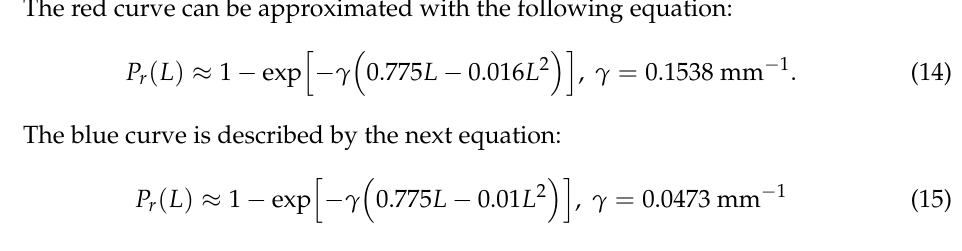
Figure 8. Dependencies of the reflection coefficient P r on the Gaussian beam width at d = 0.65 µ m, λ = 1.06 µ m, θ = 0, γ = 22.02 mm − 1 (red curve), d = 1.30 µ m, λ = 1.09 µ m, θ = 0, γ = 11.1 mm − 1 (blue curve) ( a ); d = 0.78 µ m, λ = 1.23 µ m, θ = π /18, γ = 0.15 mm − 1 (red curve), d = 1.52 µ m, λ = 1.27 µ m, θ = π /18, γ = 0.05 mm − 1 (blue curve) ( b